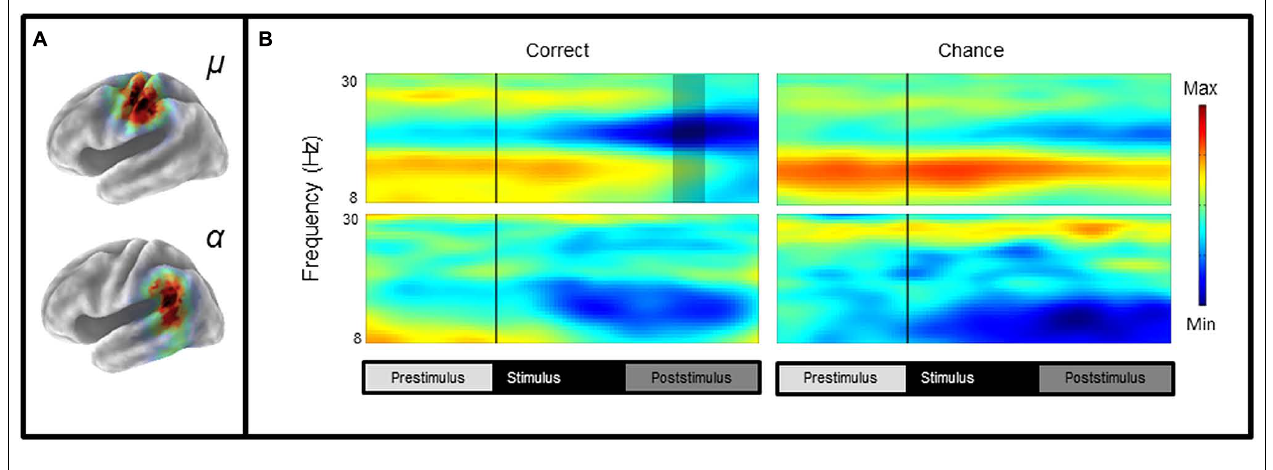
FIGURE 4 | Mean left hemisphere μ and α time-frequency ERSPs (event-related spectral perturbations) for correct and chance trials. (A) sLORETA images showing significant values in the sensorimotor and the temporal lobe regions, (B) ERSPs showing significant alpha and beta